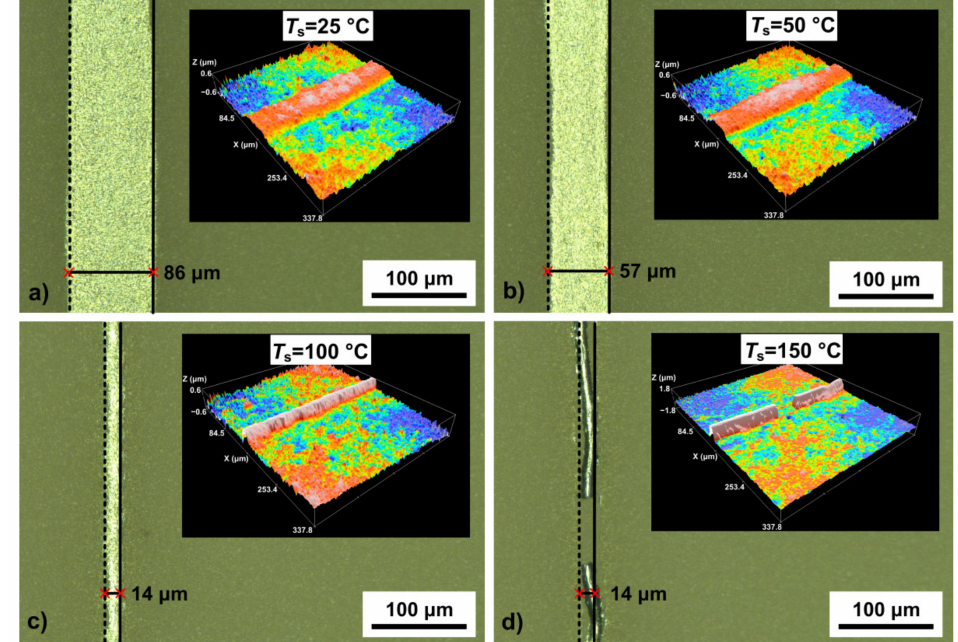
Figure 4. Optical images and profiles of platinum line (on inserts) formed at different values of substrate temperature ( a ) T s = 25 ◦ C, ( b ) T s = 50 ◦ C, ( c ) T s = 100 ◦ C and ( d ) T s = 150 ◦ C, at value of FR =